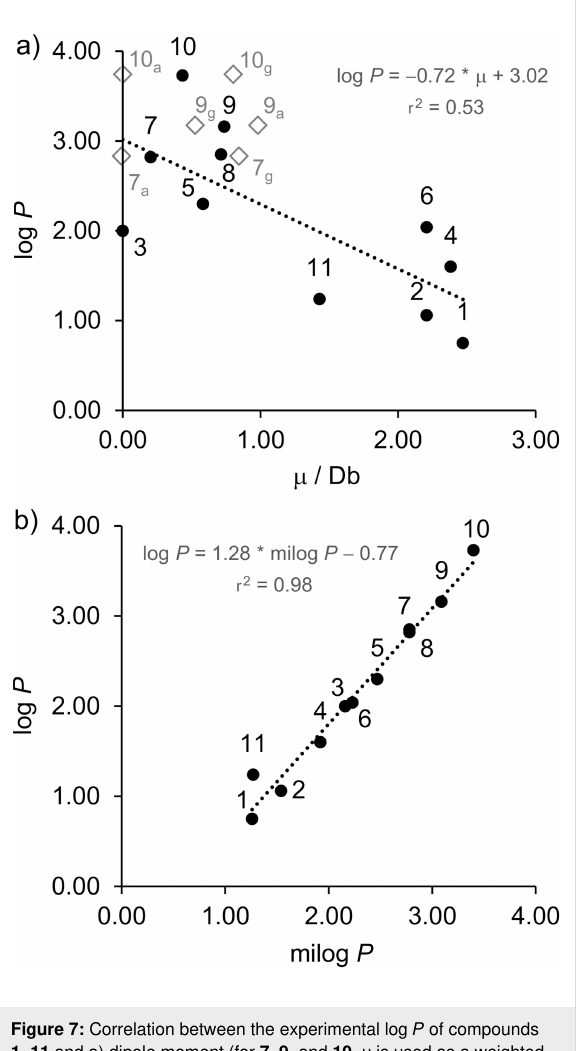
Figure 7: Correlation between the experimental log P of compounds 1 – 11 and a) dipole moment (for 7 , 9 , and 10 , μ is used as a weighted average of the gauche and anti -conformers), and b) predicted log P (milog P